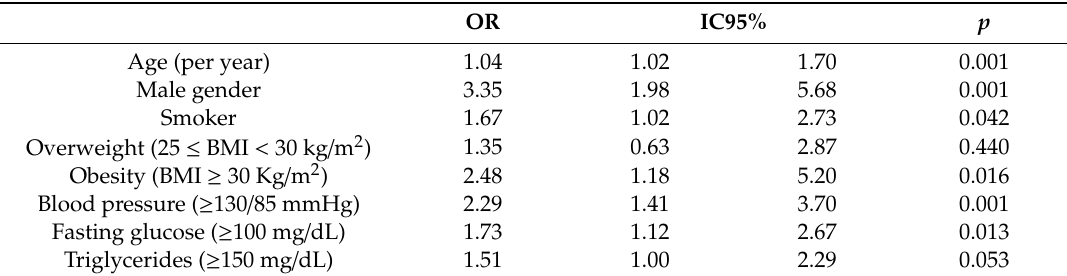
Table 2. Risk factors associated with early kidney